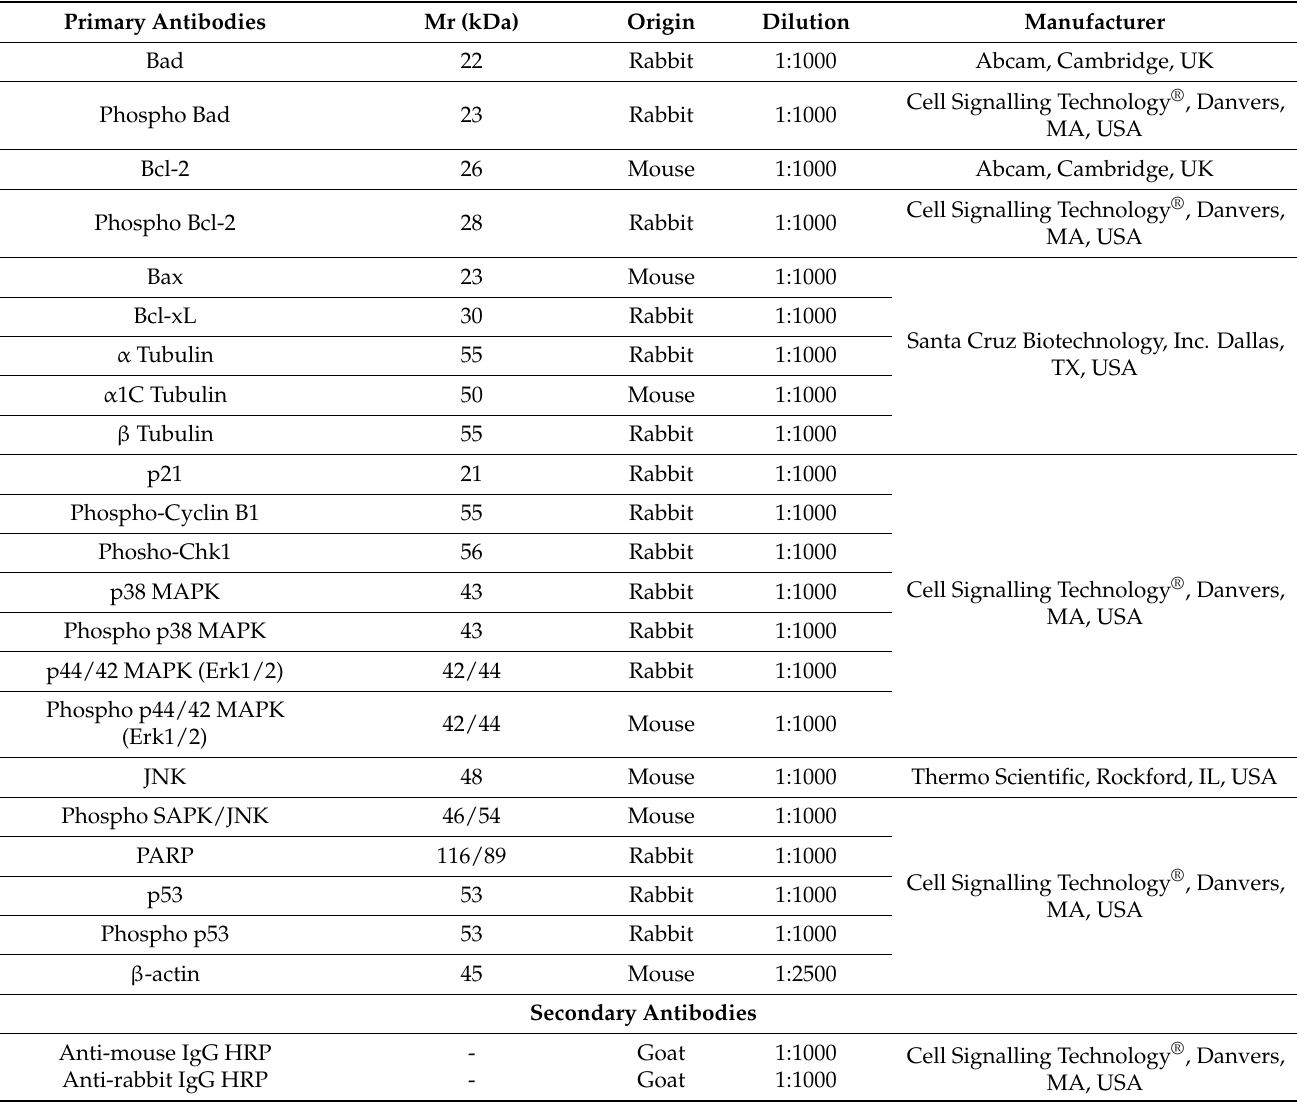
Table 6. List of Western blot